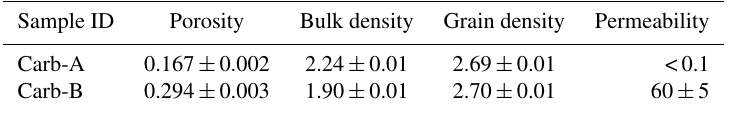
Table 1. Helium bulk and grain density (in gcm − 3 ), helium porosity (in PU), and air permeability (in mD) measured at benchtop conditions for Carb-A and Carb-B. Permeability of plug Carb-A is below the sensitivity level of the apparatus used (0.1mD). Values are from Vialle et al. (2013).